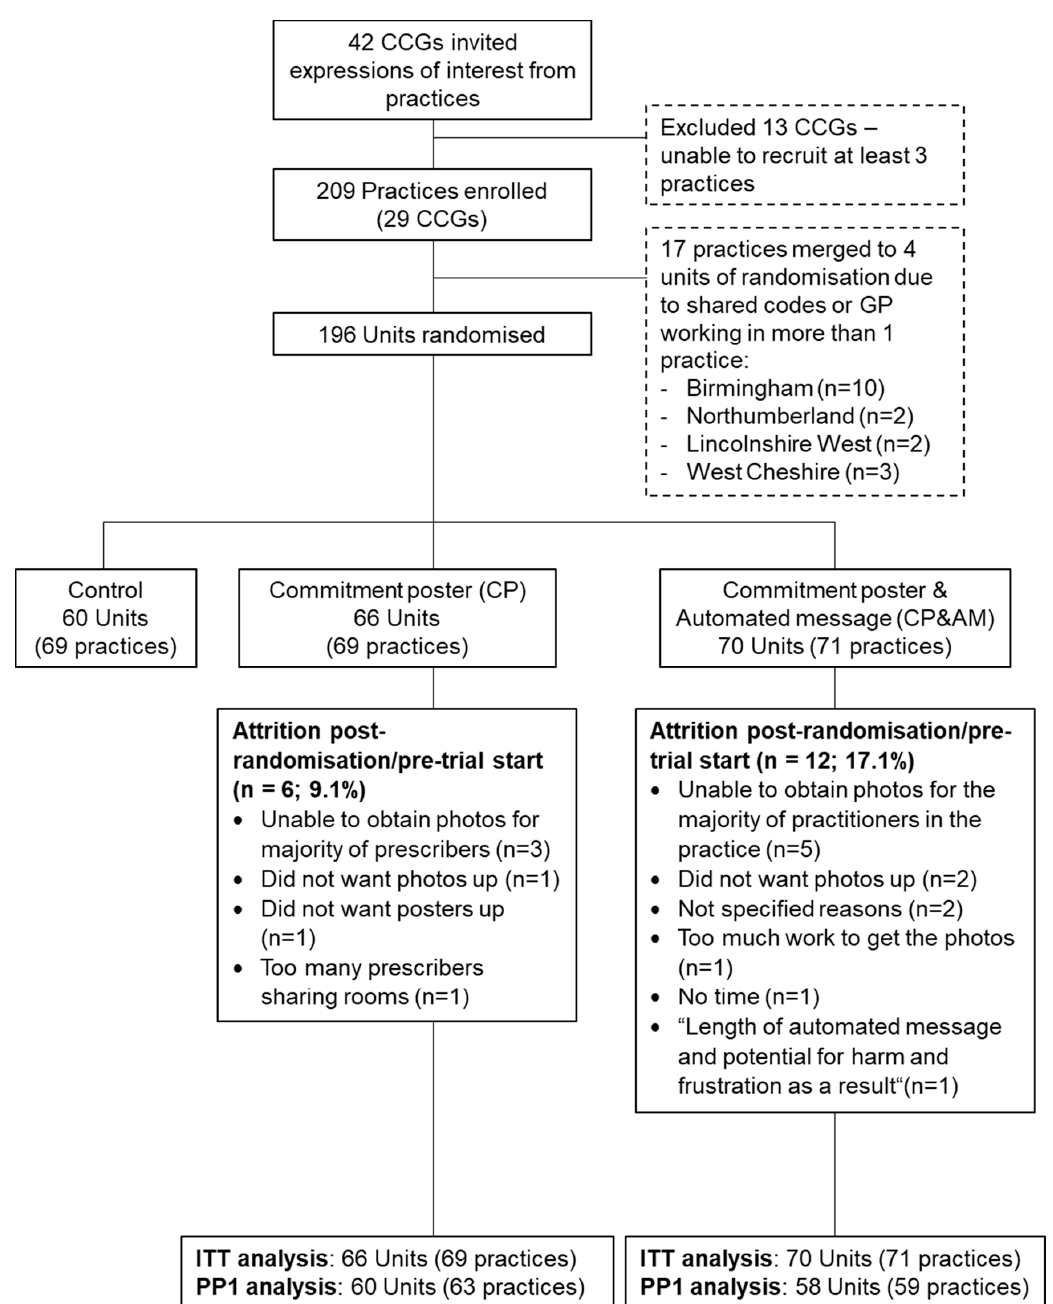
Figure 1. Flow of participating practices.